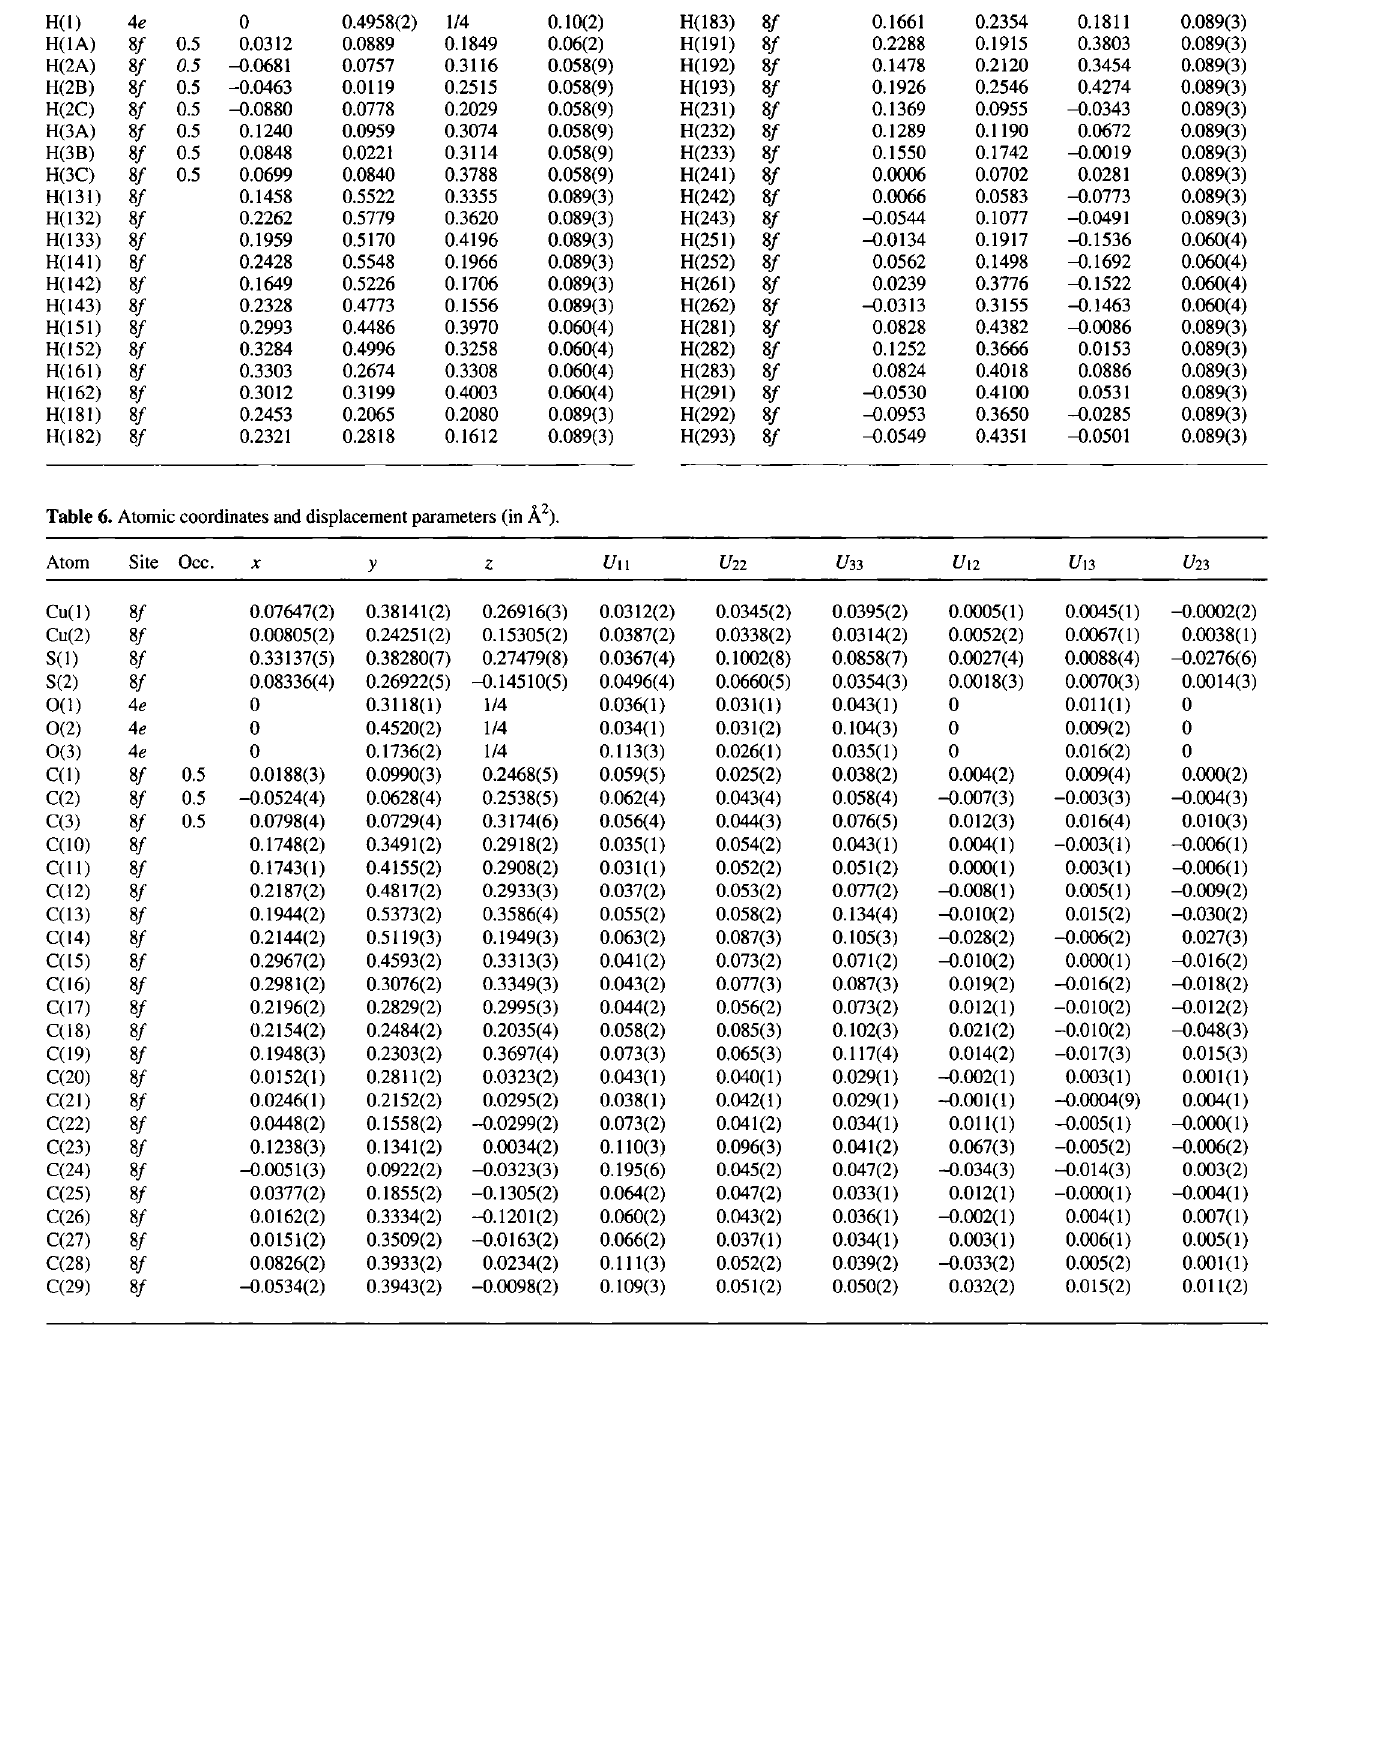
Table 6. Atomic coordinates and displacement parameters (in Ä 2